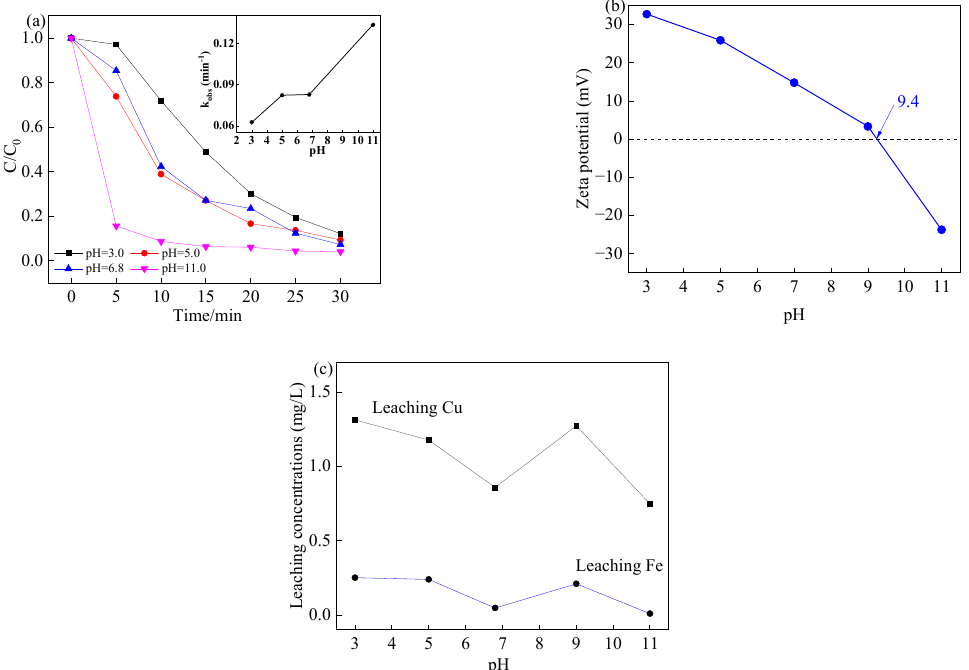
Figure 7. ( a ) Effect of pH value on BPA removal in LCFO-4/PMS systems; ( b ) zeta potential of LCFO-4; ( c ) metal leaching under different pH value. Conditions: C 0 = 0.05 mM, [LCFO-4] = 0.7 g/L, [PMS] = 10.0 mM.